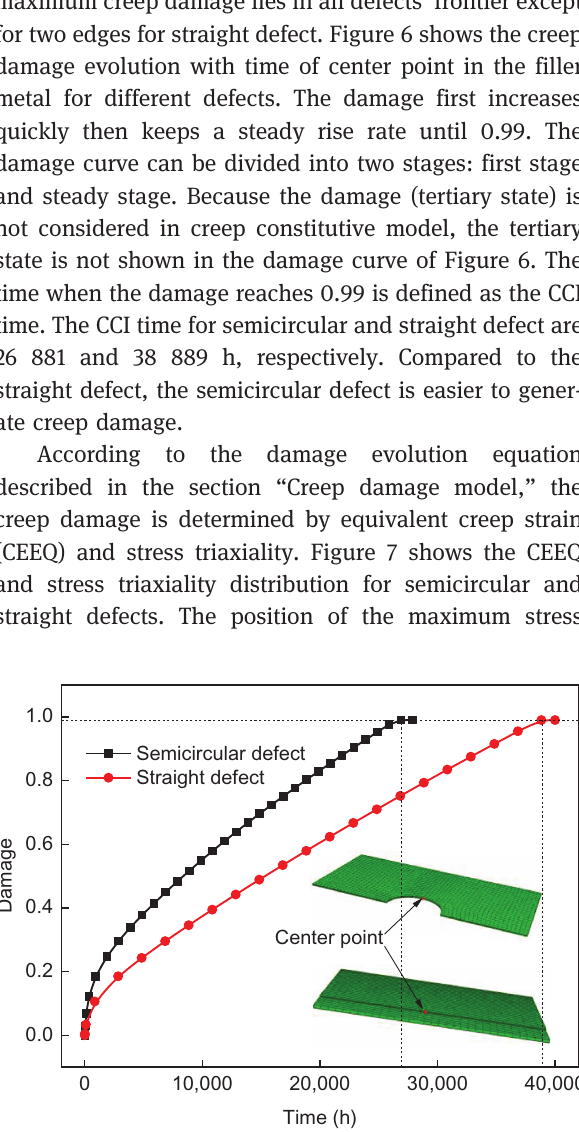
Figure 6: Damage evolution with time of center point in filler metal for different defect